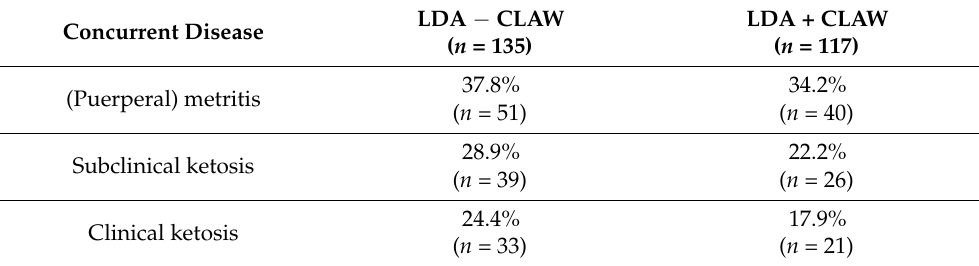
Table 3. Distribution of concurrent diseases in animals diagnosed with left displacement of the abo- masum (LDA) and either no claw lesion (LDA − CLAW) or at least one claw lesion (LDA + CLAW). Distribution is given as % of the total number of each LDA − CLAW and LDA +